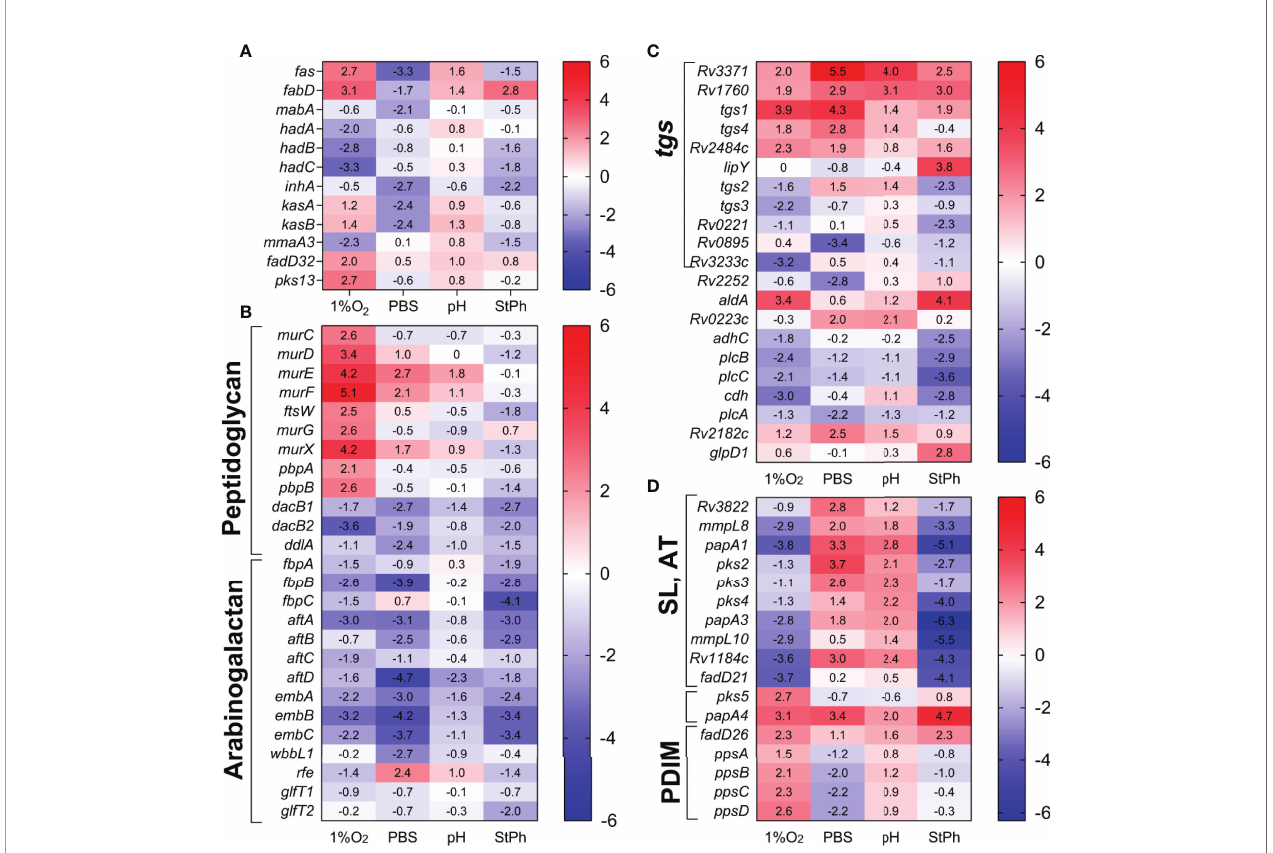
FIGURE 5 | Heat map of genes differentially expressed in lipid biosynthesis and metabolism: (A) fatty acid and mycolic acid biosynthesis, (B) peptidoglycan and arabinogalactan synthesis, (C) glycerolipid metabolism (tgs , triacylglycerol synthase), (D) methyl-branched lipid biosynthesis [sulfolipids (SL), acylated trehaloses (AT), PDIMs]. The log2 fold change for each gene and condition is indicated in the